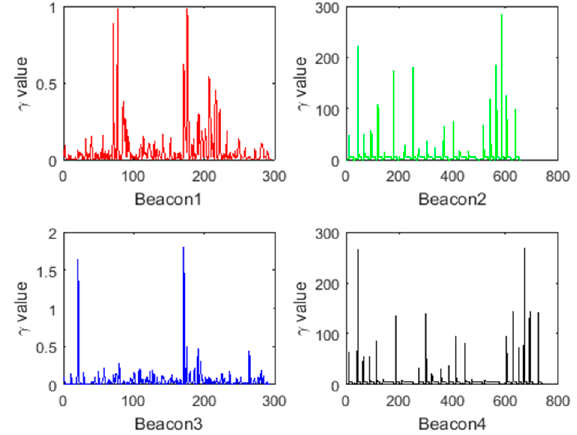
Figure 18. The values of (cid:2011) (cid:3038) for the four beacons computed alongRoute 2.